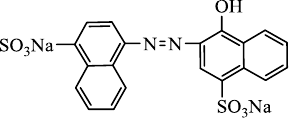
Figure 5. Constitutional formula of Acid Red